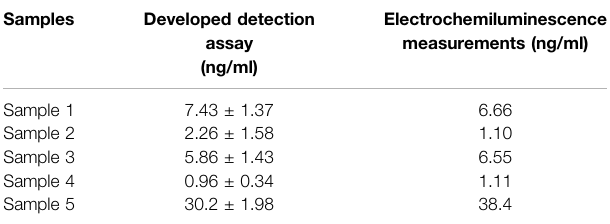
TABLE 1 | [CEA] in the blood samples was measured using the developed assay and the electrochemiluminescence measurements.